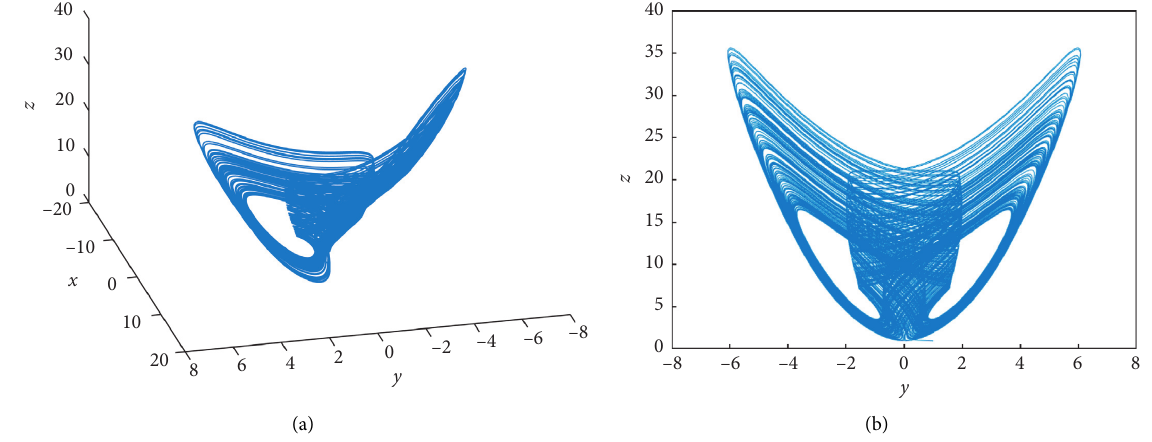
Figure 1: Phase portraits of the fractional system with α � 0 . 95.